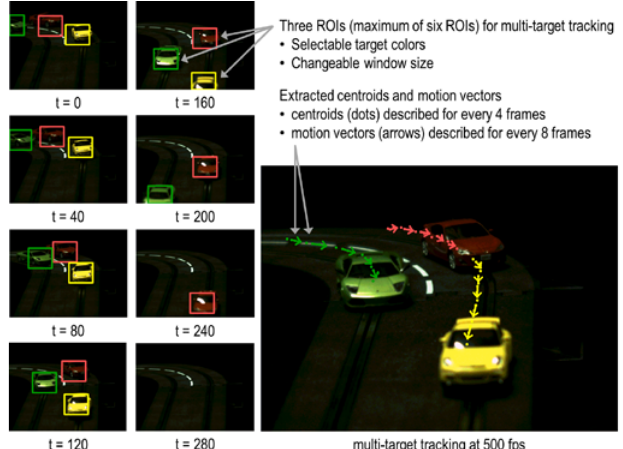
Figure 17. Multi-target tracking. Left-hand images array tracking result time series order and right- hand image shows motion vector and